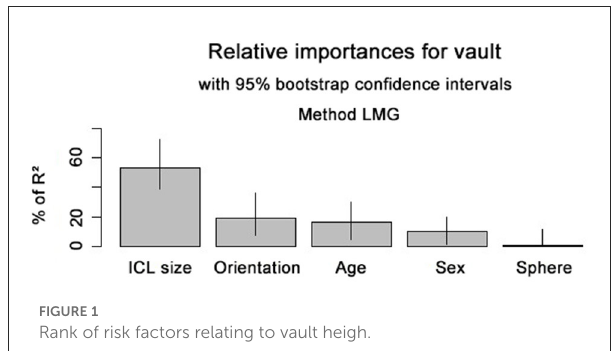
FIGURE1 Rank of risk factors relating to vault heigh.